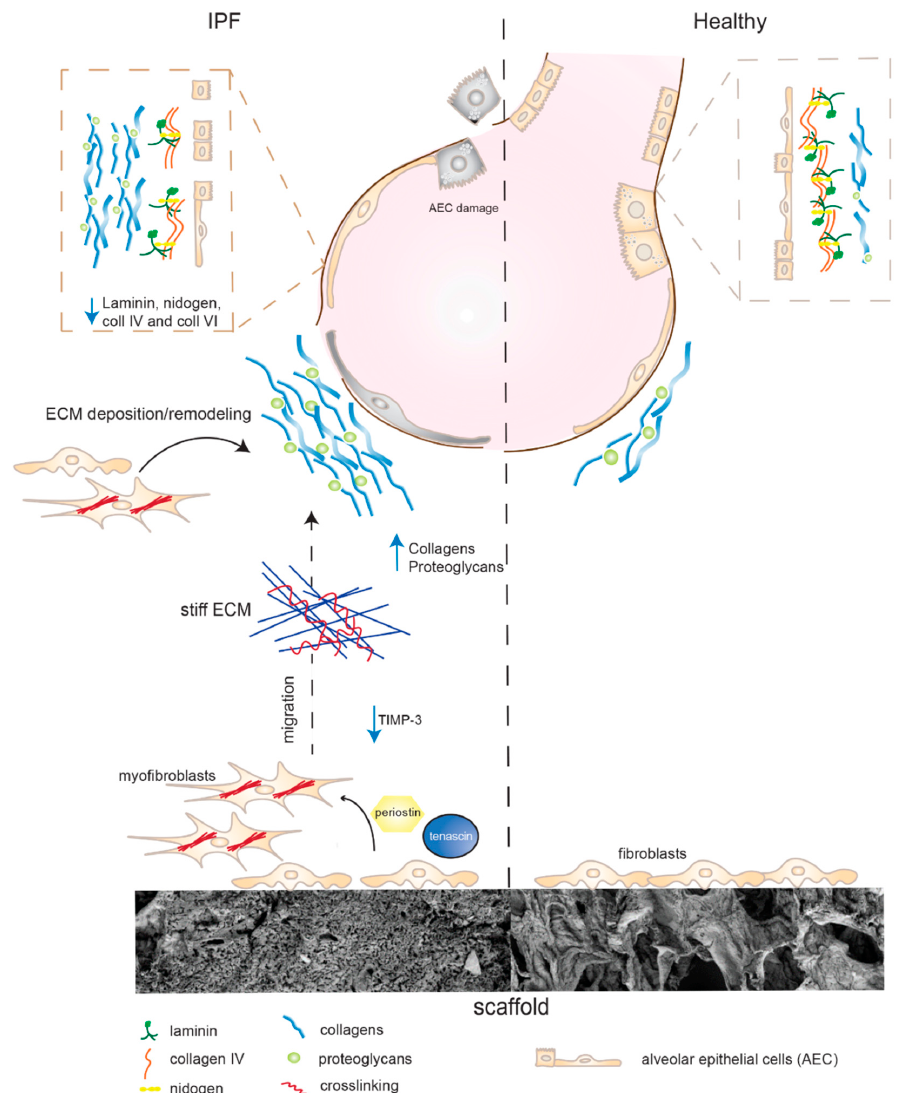
Figure 7. Cell-matrix interactions in IPF. Fibroblasts cultured on stiff IPF scaffolds secrete increased amounts of periostin, known to stimulate myofibroblast differentiation and migration. Increased synthesis of tenascin and reduced levels of metalloprotease inhibitors (TIMP-3) support migration and movement toward stiffer tissue. Fibroblasts become activated and generate increased deposition and build-up of collagens and proteoglycans (decorin, versican, and biglycan). Alveolar epithelial cell (AEC) damages causes basement membrane disruption and the loss of structural barriers. Fibroblasts on IPF scaffolds reduced their production of BM complexes (laminins, nidogens, and collagen IV), potentially hindering the rebuild of a functional BM for anchoring AEC.